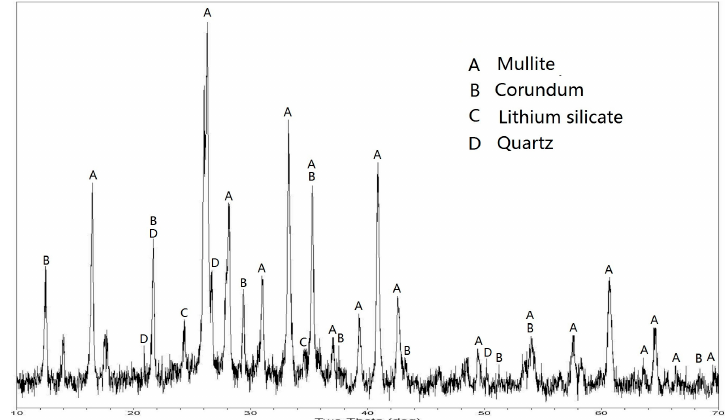
Figure 4. XRD pattern of raw CFA sample.